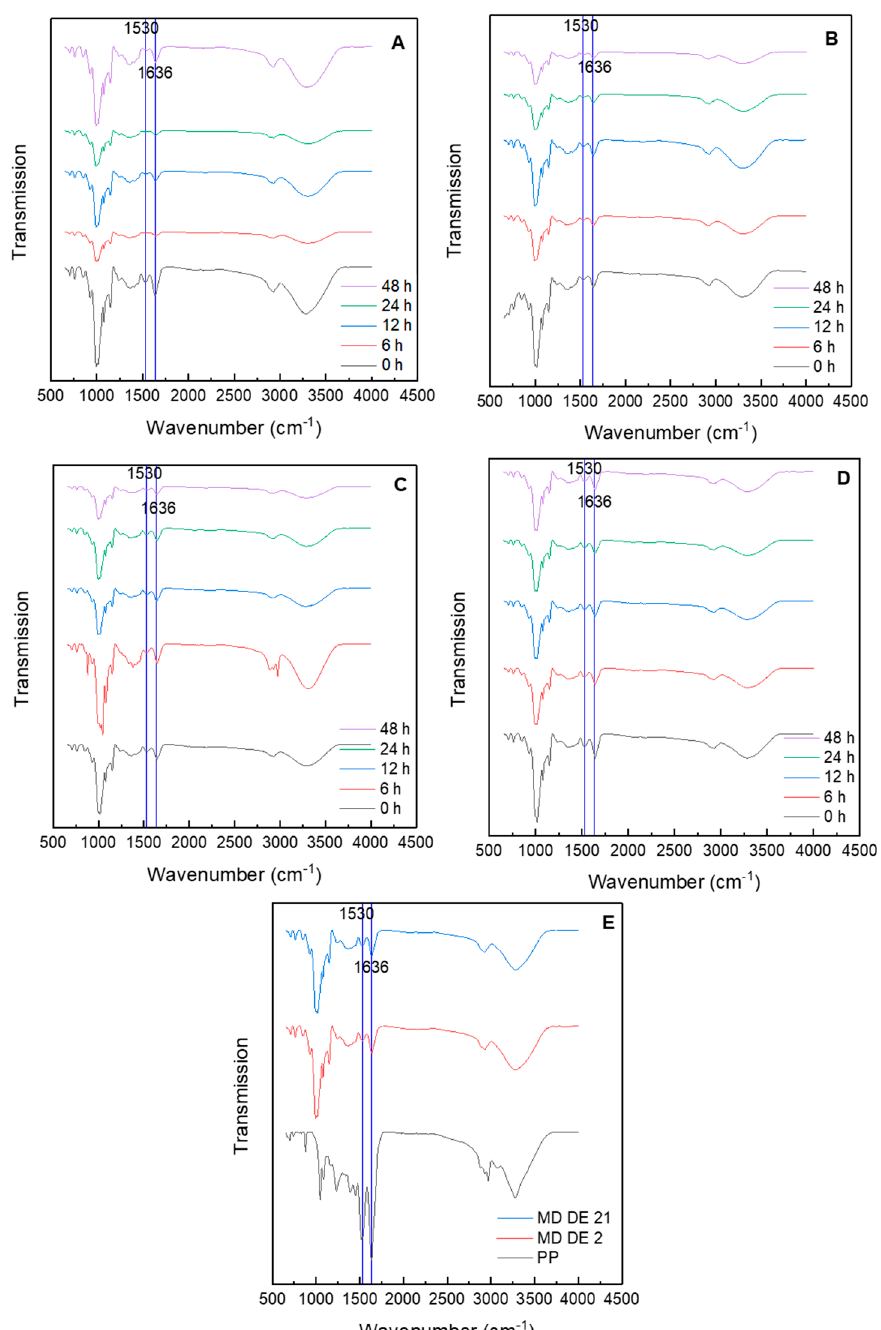
Figure 6. FTIR spectra of the fibers from blend ( A ) (80:10:5), ( B ) (80:10:10), ( C ) (80:10:15), and ( D ) (80:10:20) unheated and after 6, 12, 24, and 48 h of heating at 65 °C and 75% RH as well as ( E ) maltodextrins MD DE21, MD DE 2, and potato protein PP.